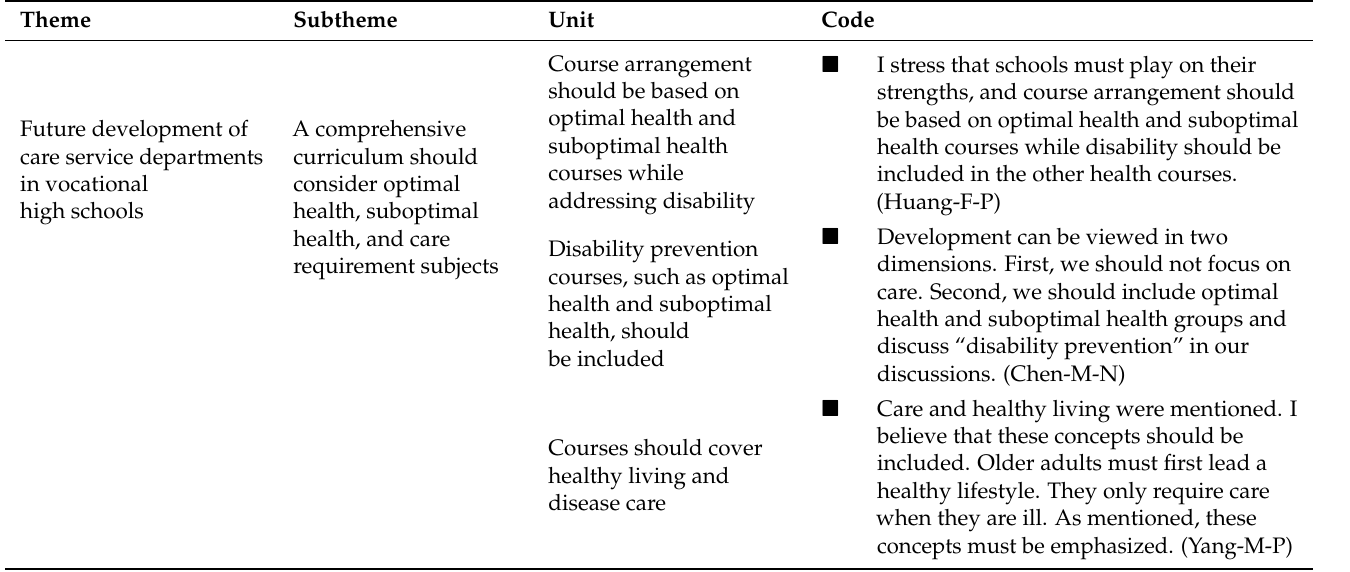
Table 1. Example of a data analysis